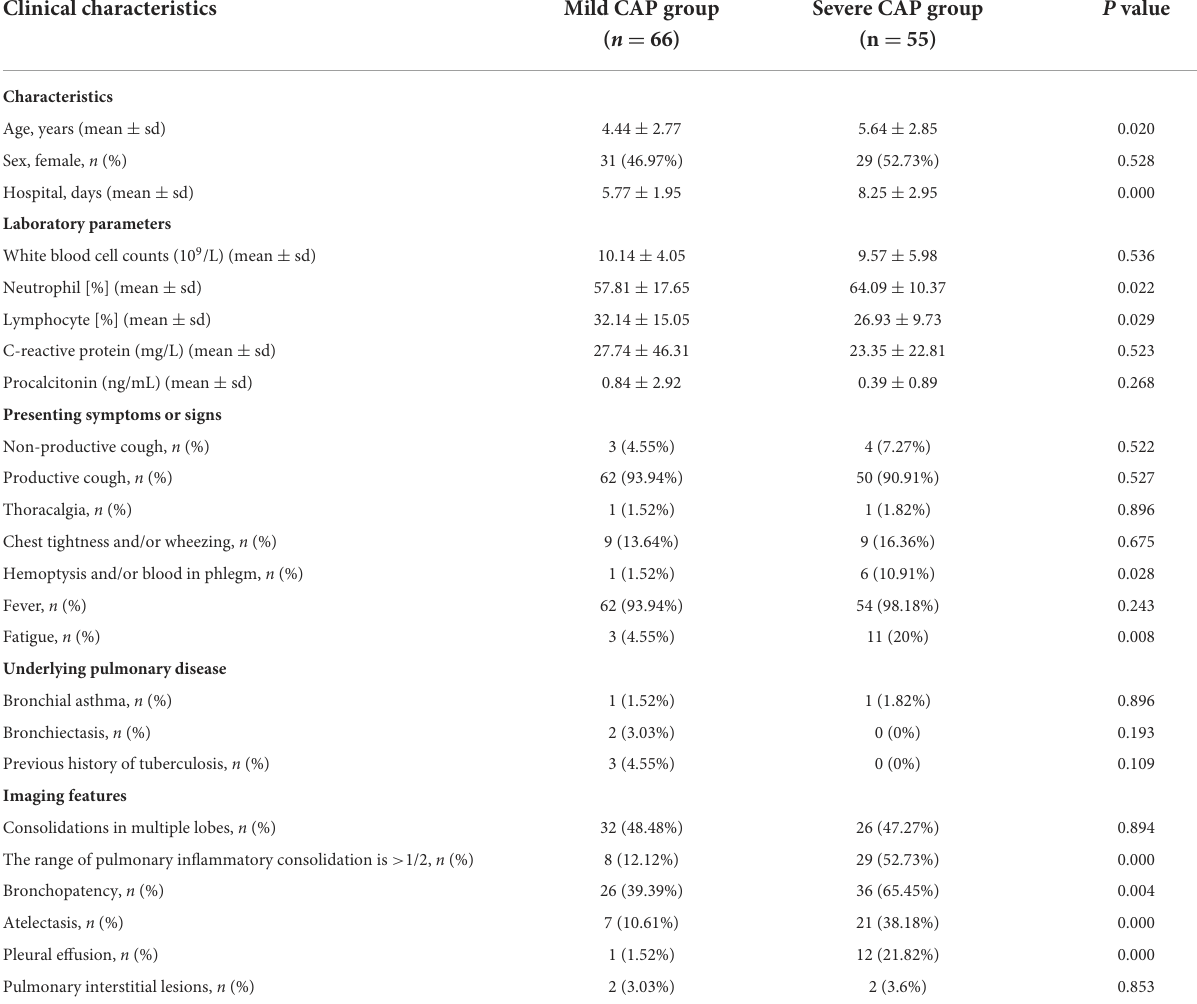
TABLE 1 Comparison of clinical features of patients with mild and severe community-acquired